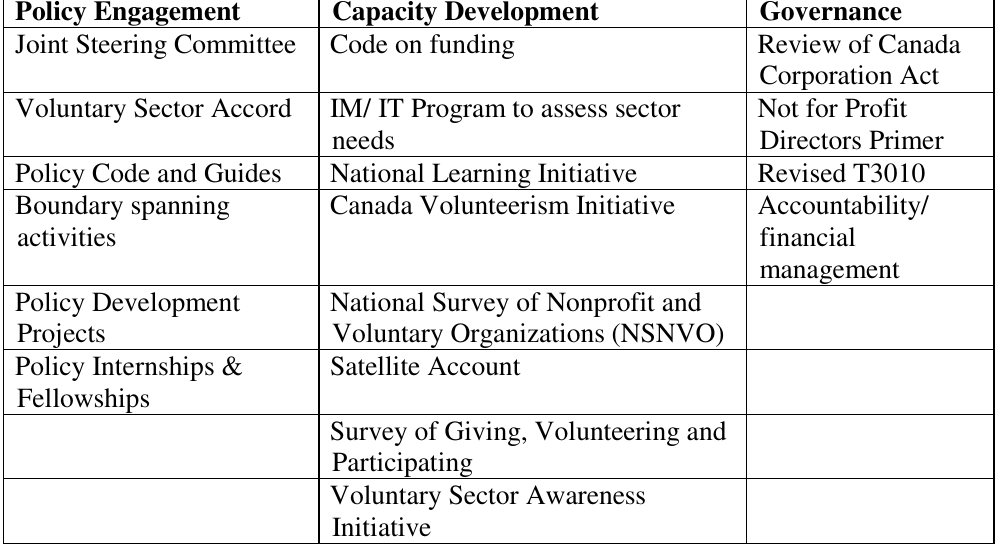
Table 1: Voluntary Sector Initiative Programs